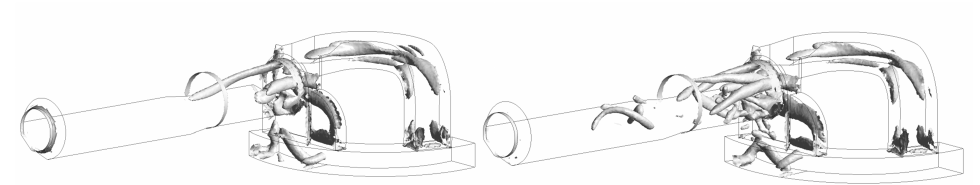
Figure 12. Visualization of vortices by isosurfaces of the vortex identification parameter, the Q- criterion. Results from the two-equation turbulence model k − ε to the left and the Reynolds stress model RSM-BSL to the right. Figure adapted from [11]. Reprinted with permission from the Society for Mining, Metallurgy & Exploration.